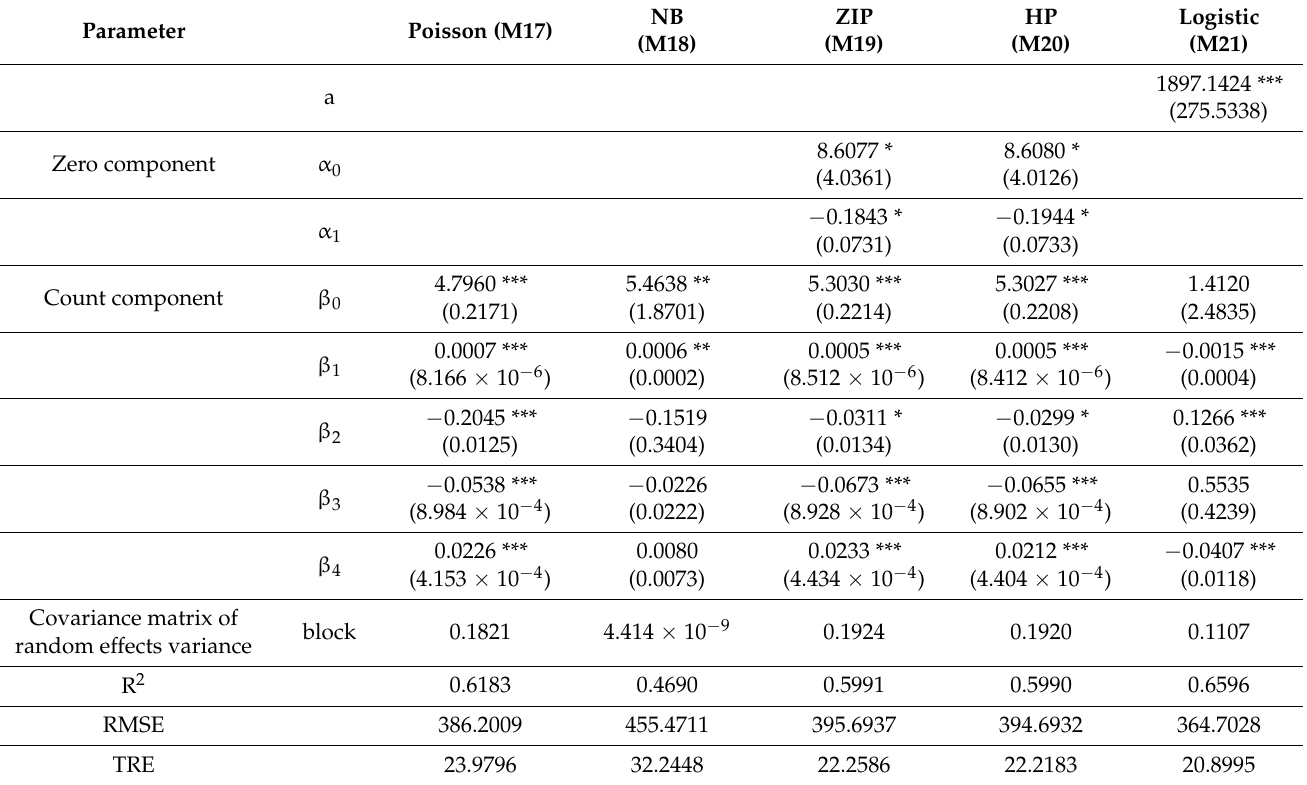
Table 5. Parameter estimates and fit statistics of the one-level nonlinear mixed-effects DBS models (Equations (1) – (3), (5), and (7)).